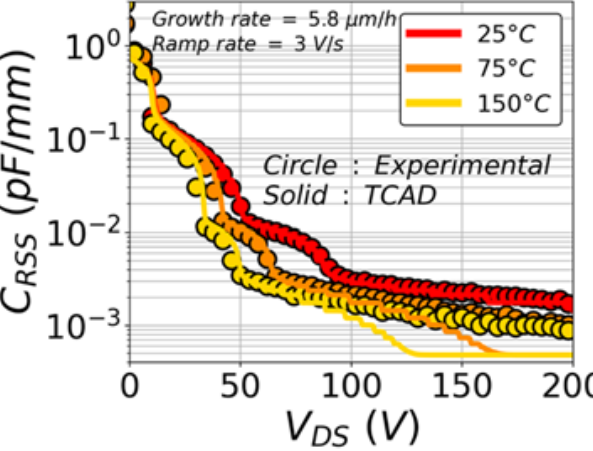
Figure 11. TCAD fit of the experimental data with a GaN:C epitaxial growth rate of 5.8 μ m/h and a ramp rate of 3 V/s with simulation for which the [A] is equal to 1 a.u. in the Al x Ga 1-x N buffer layers and 0.5 a.u. in the GaN except for the last two hundred nanometers ([A] − [D] of 1 × 10 17 cm − 3 ; E A -E V = 1.1 eV; σ A,h + = 1 × 10 − 13 cm 2 ).